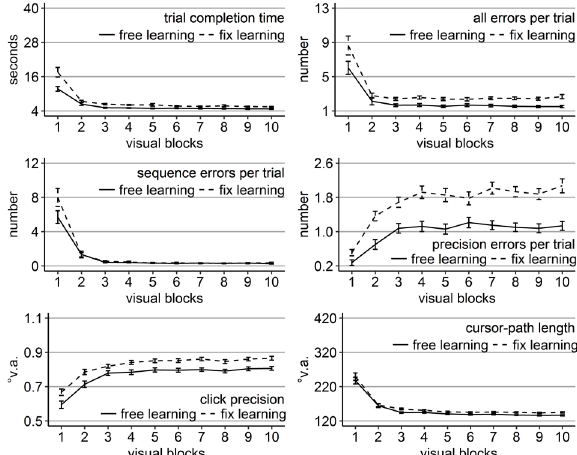
Figure 8. Performance measures during the learning phase of Experiment 4: Trial completion time in seconds, numbers of all errors, sequence errors, and precision errors per trial, click precision in °v.a., and cursor-path length in °v.a. (y-axes) over the course of the ten visual blocks (x-axes) for the two learning groups (free gaze as solid line and fix gaze as dashed line). Error bars represent standard errors of the mean.